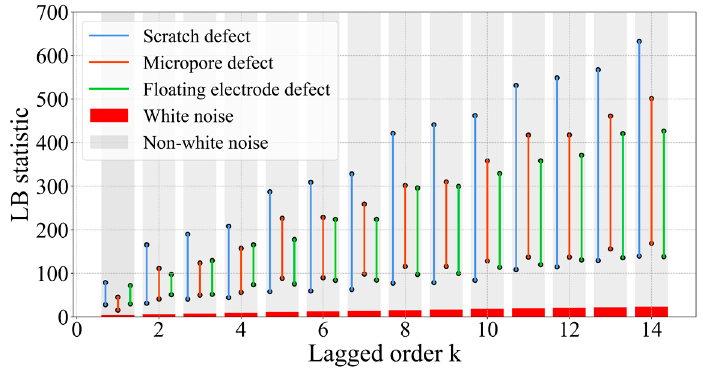
Figure 5. LB test results.